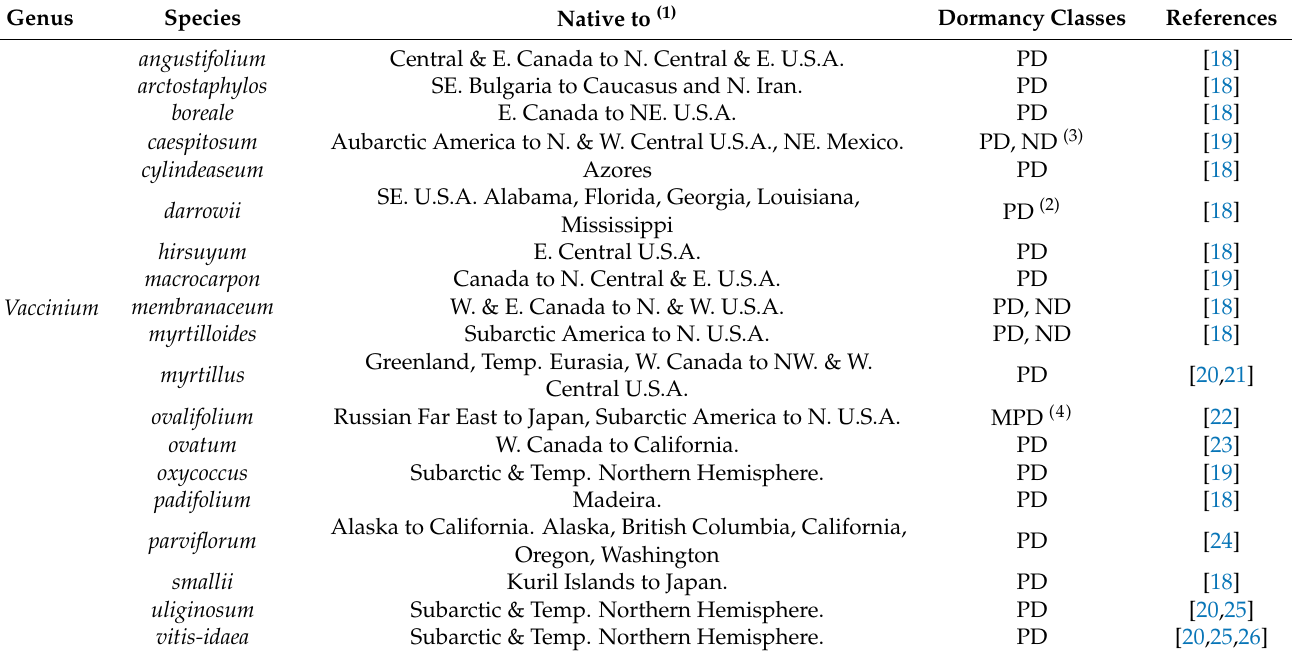
Table 3. Seed dormancy classes in Vaccinium